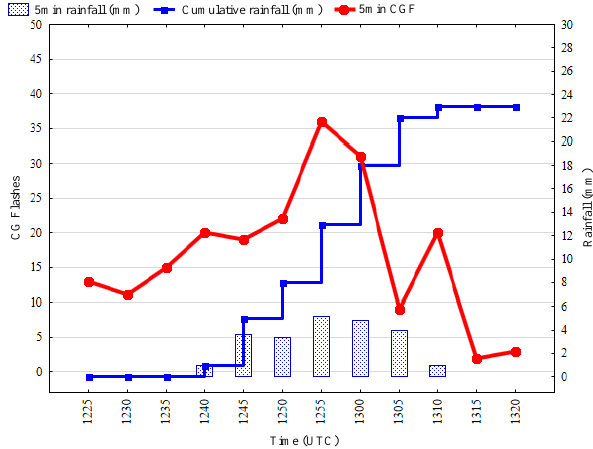
Figure 8. Critical interval time series for debris flow event of 12 June 1997. This is an event from the STH group and debris flow initiation was observed at